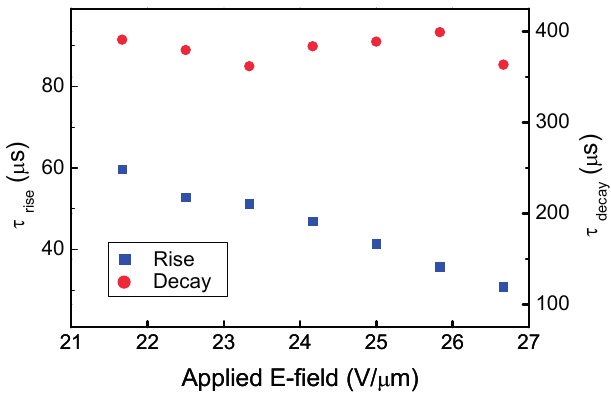
Figure 2. Electric field dependence of the rise and decay times of the polymer/ChLC nano-composite with 8 wt % chiral dopant concentration after polymerization.